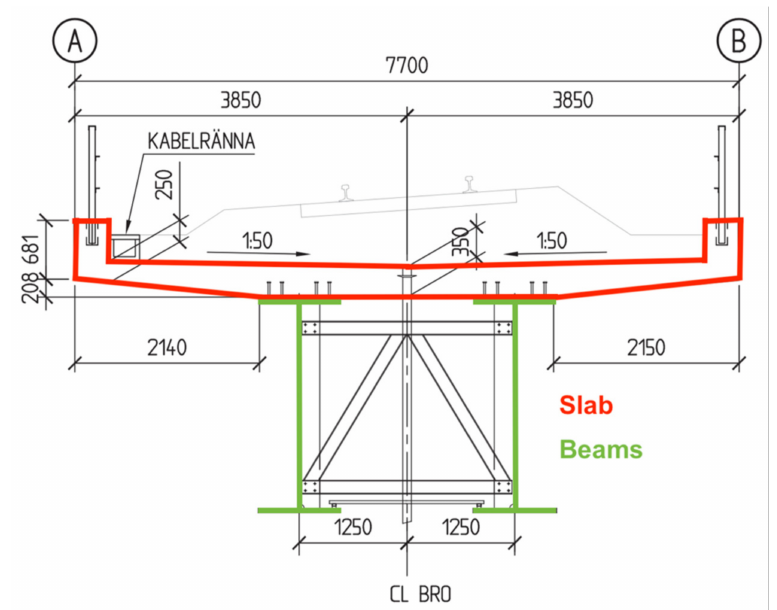
Figure 1. Cross-section of the Banafjäl Bridge, a railway structure of the Bothnia Line in Sweden. The bridge shows a typical simple girder bridge cross-section with two girders. Source: Royal Institute of Technology (single column, B&W in the printed version).